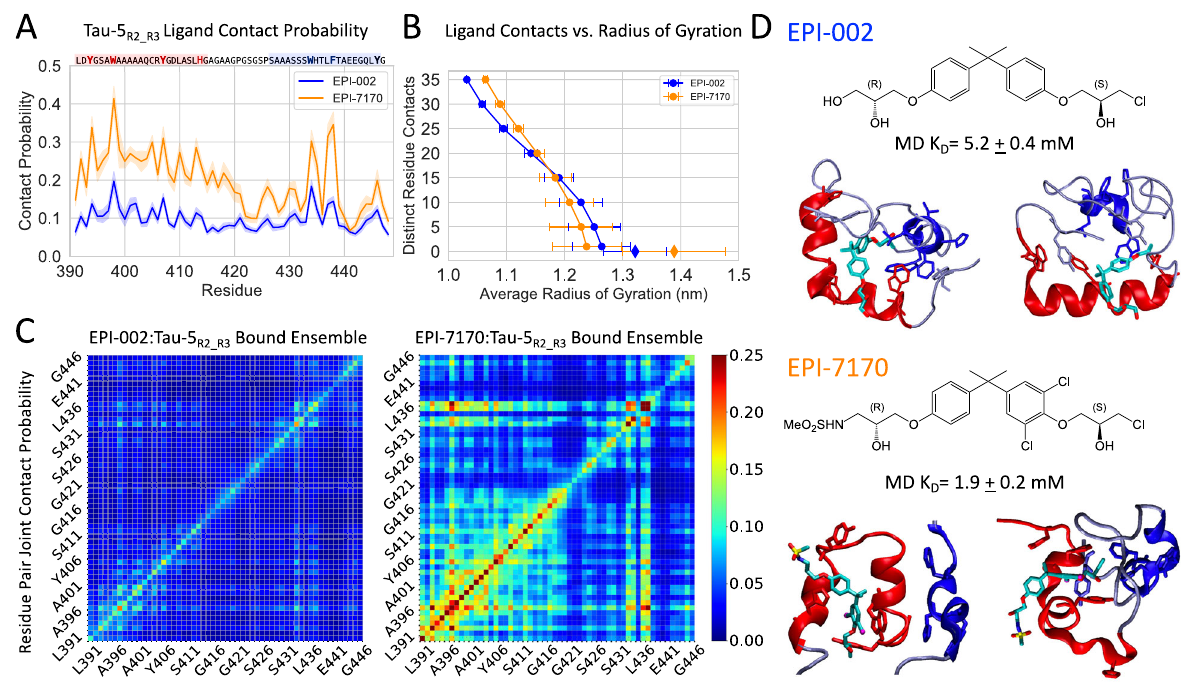
Fig. 2 | Molecular dynamics simulations of EPI-002 and EPI-7170 binding the disordered Tau-5 R2_R3 region of the androgen receptor N-terminal transacti- vation domain. A Per-residue contact probabilities were observed between Tau- 5 R2_R3 and EPI-002(blue) and EPI-7170(orange)inREST2MD simulations.Contacts are de fi ned as occurring in frames where any non-hydrogen ligand atom is within 6.0Å of a non-hydrogen protein atom. Contact probabilities are reported as mean values±statistical error estimates from blocking. B Average C α -atom radius of gyration (R g ) ofTau-5 R2_R3 conformations asa function ofthe minimum number of distinctresiduecontactsformedinMDsimulations.Valuesarepresentedasmeans anderrorbarsre fl ectthevarianceofR g valuesobservedineachsubsetofTau-5 R2_R3